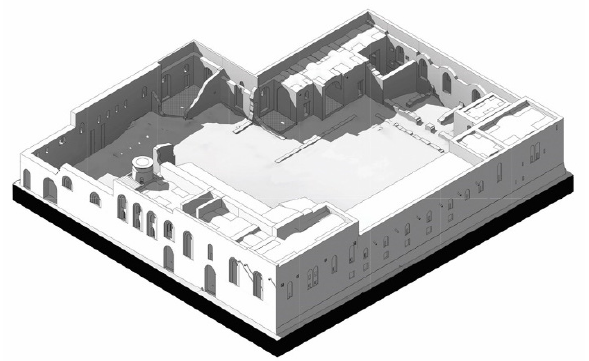
Figure 9. Parametric model of pointed crossvault.